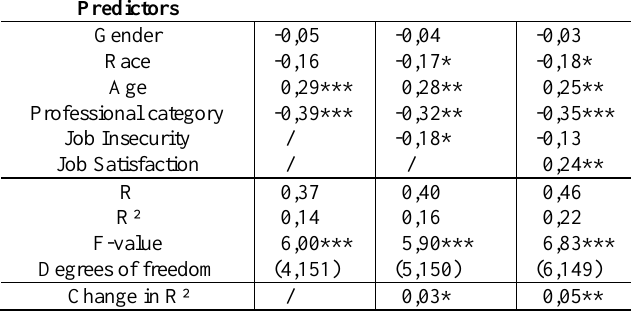
Table 6: Results of a regression analysis with affective organisational commitment as dependent variable, and background characteristics, job satisfaction and job insecurity as predictors